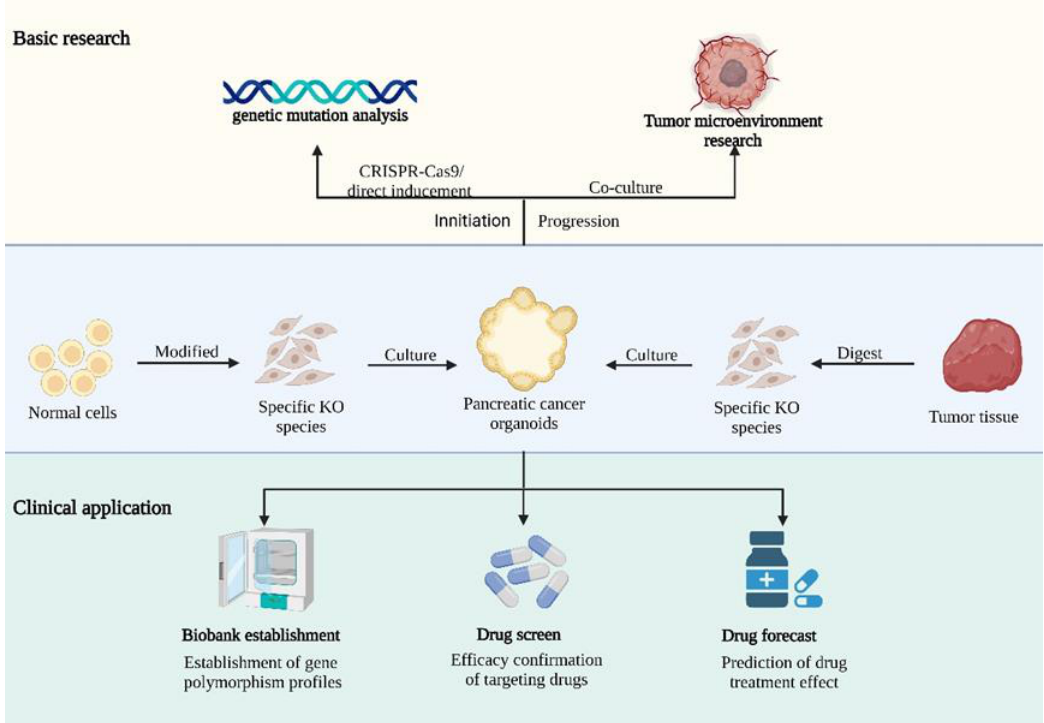
Figure 2. Illustration of pancreatic cancer organoid applications. Pancreatic organoids are of great importance in both basic research and clinical settings. In basic research, gene-edited specific organ- oids have furthered the study of cancer development and progression. In clinical applications, or- ganoids are involved in the diagnosis and treatment of patients through the construction of bi- obanks, drug screening, and the evaluation of therapeutic options using a variety of strategies. (Cre- ated with biorender.com)